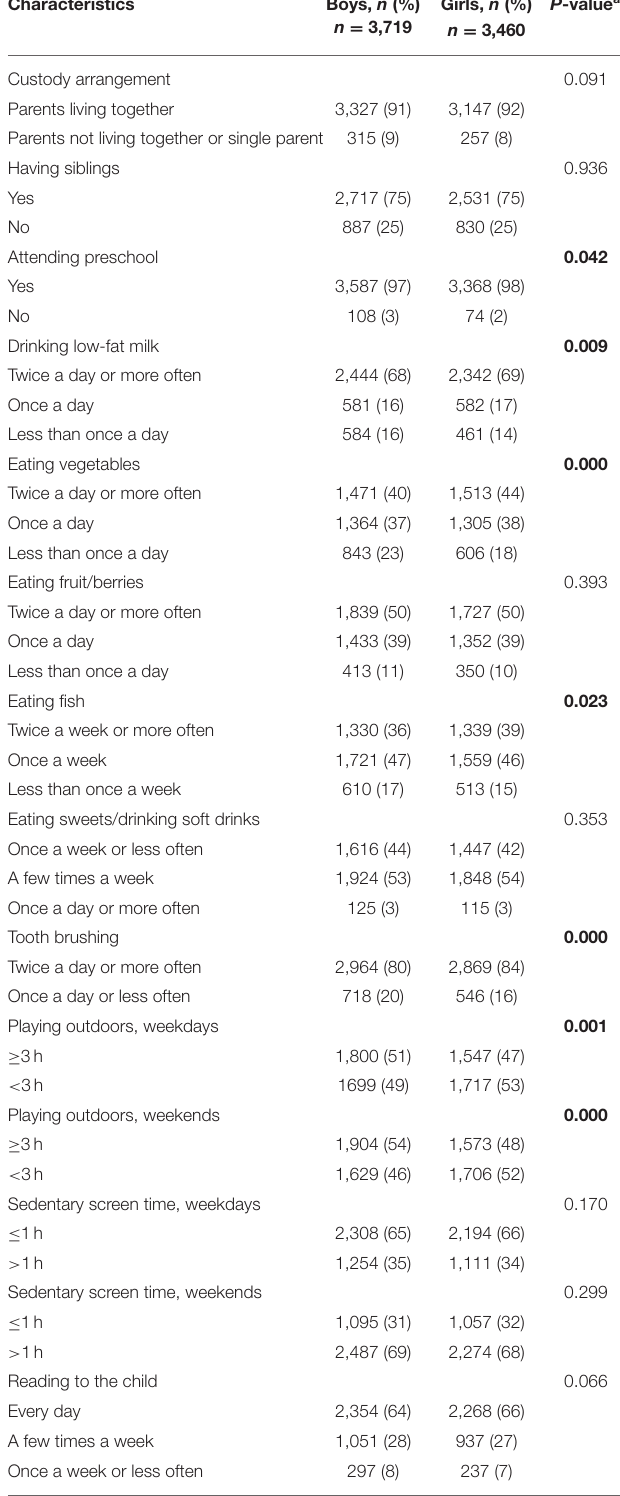
TABLE 1 | Characteristics of 3-year-olds within the Salut Child Health Programme (2014–2017).